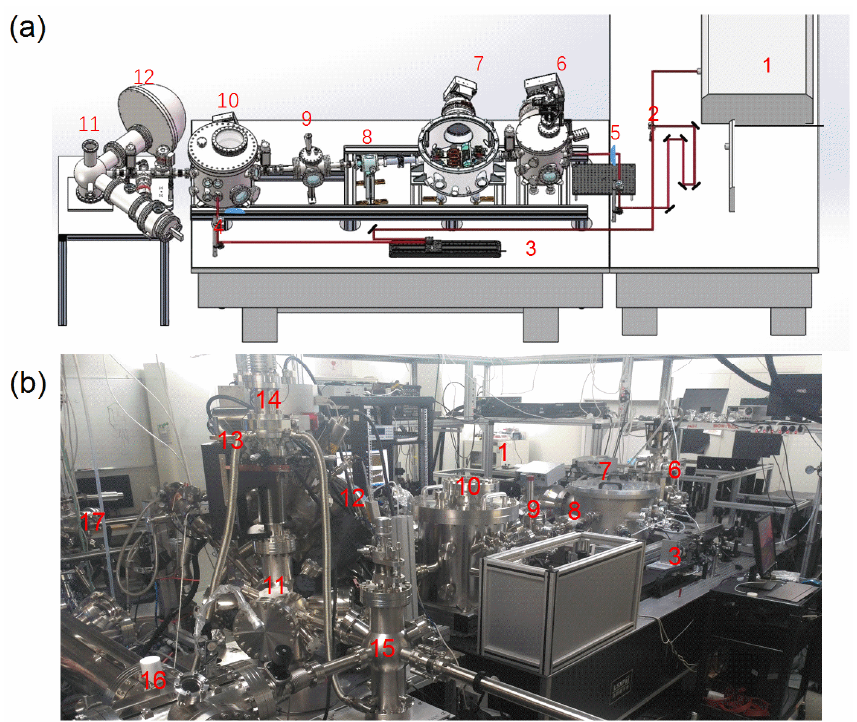
Figure 2. The EUV Beamline: ( a ) engineering drawing and ( b ) laboratory picture. (1) TiS laser driver; (2) Laser beam-splitter; (3) Delay line; (4) Focusing lens for excitation pulse); (5) Focusing lens for HHG; (6) HHG EUV source; (7) EUV monochromator; (8) monochromator exit slit; (9) EUV detector chamber; (10) Focusing and recombination chamber; (11) Spin-ARPES spectrometer chamber; (12) Spin-ARPES hemispherical analyzer; (13) Liquid Helium cooling pipes; (14) 4-axis manipulator for sample; (15) Load lock for sample material; (16) Transfer tube bringing sample material from materials engineering stations; (17) MBE-2 materials engineering